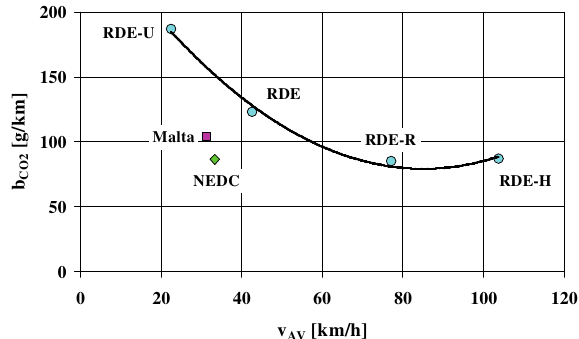
Fig. 15. The relation between the mean absolute value of the velocity and acceleration product – A on the mean speed – v AV in each of the test cycles